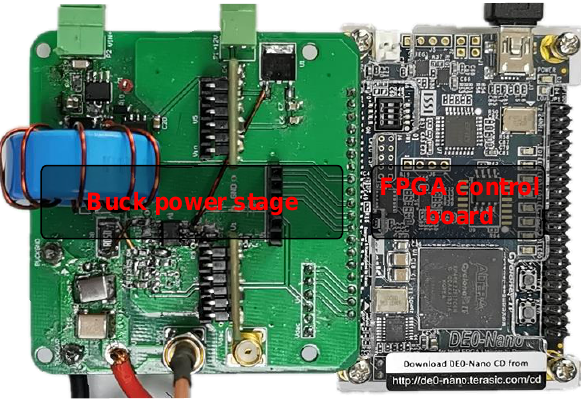
Figure 13. The experimental prototype.